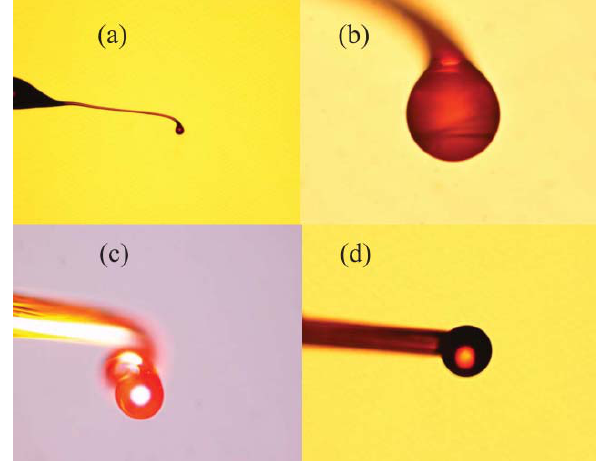
Figure 6. ( a ) Microscope image of the chalcogenide glass microsphere sample with different diameters; ( b ) 53 μ m; ( c ) 98 μ m; ( d ) 109 μ m; Reprinted/Adapted with permission from [70].